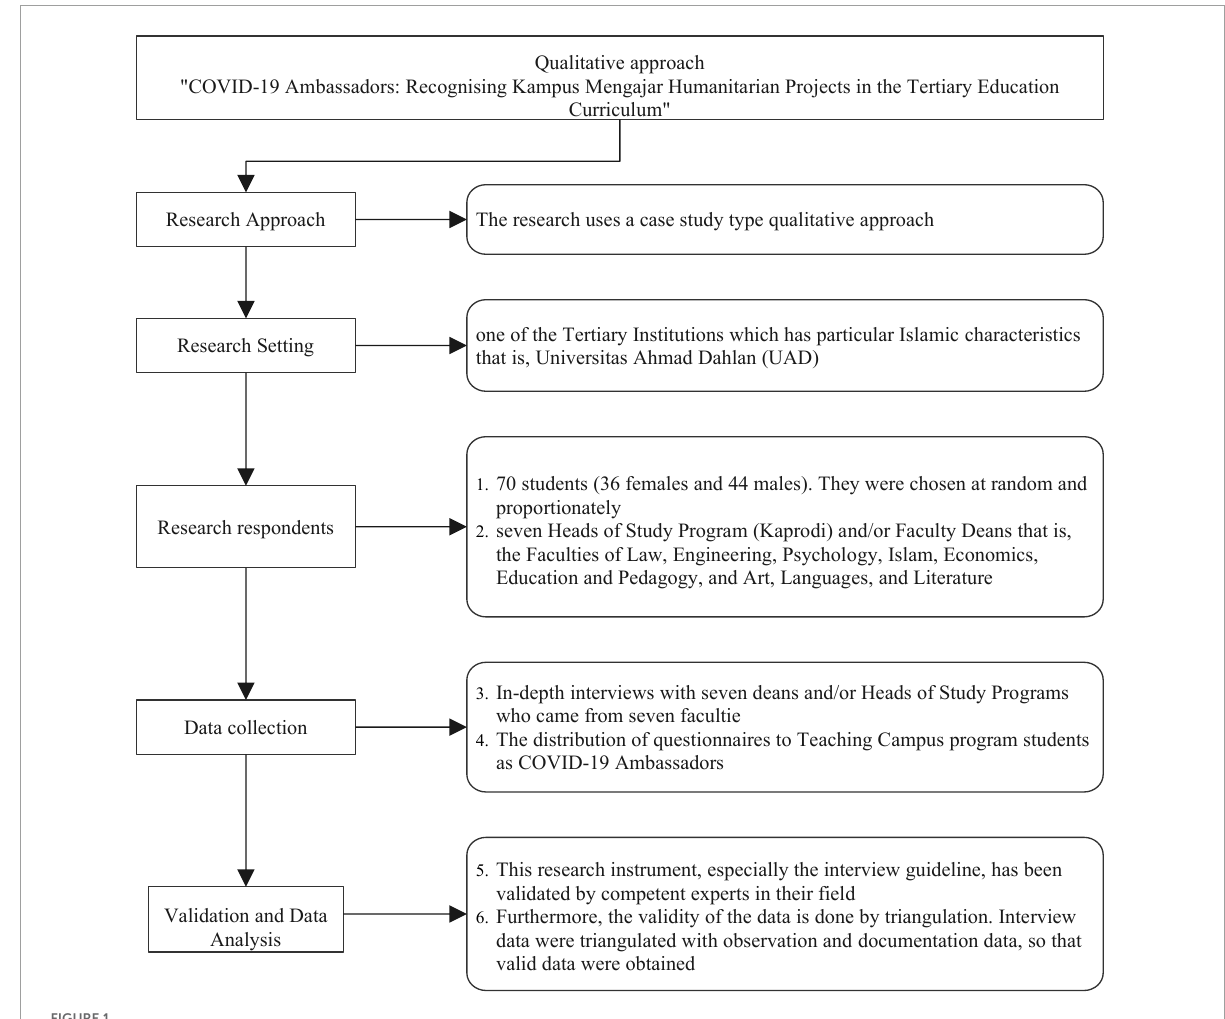
FIGURE1 Flowchart of research on COVID-19 ambassadors: Recognizing Kampus Mengajar humanitarian projects in the tertiary education